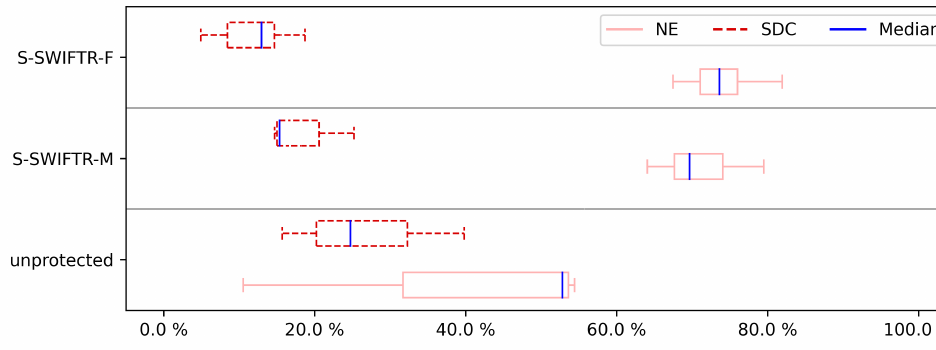
Figure 15. CFE small scale factory fault injection results for 2 registers.